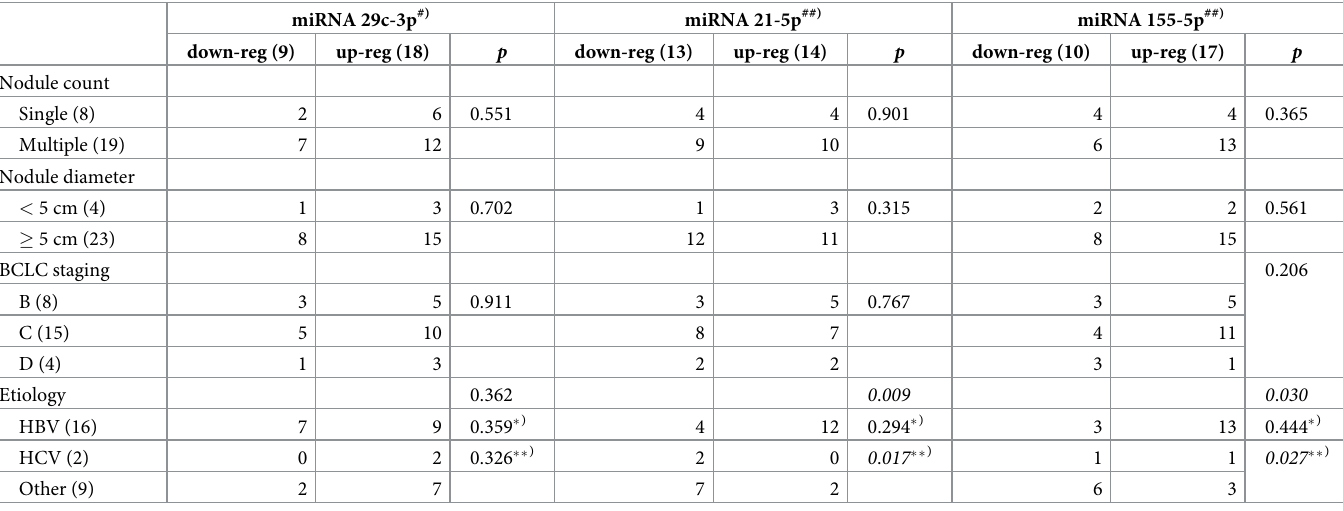
HCC: hepatocellular carcinoma; HBV: hepatitis B virus; HCV: hepatitis C virus; up-reg: up-regulation; down-reg: down-regulation. BCLC: Barcelona Clinic Liver Cancer #) miRNA29c-3p as tumor suppressor; ##) miRNA21-5p and miRNA 155-5p as oncomiRs; � ) HBV vs. HCV; �� ) HBV vs. other; significant value of p <